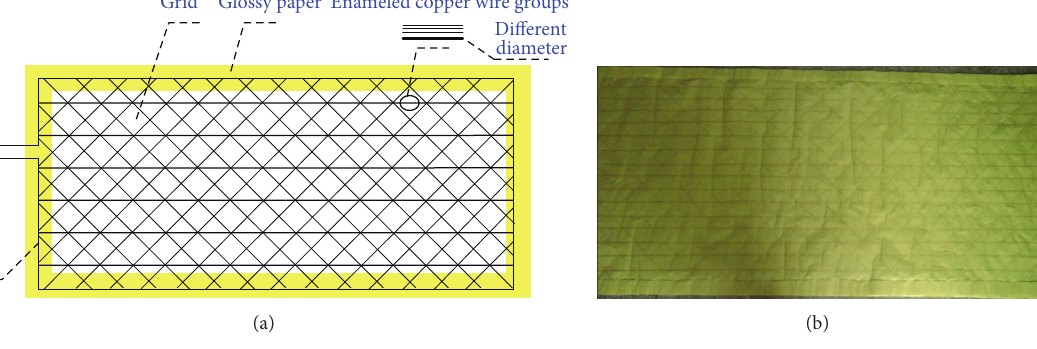
Figure 4: Smart film: (a) schematic and (b) photograph.